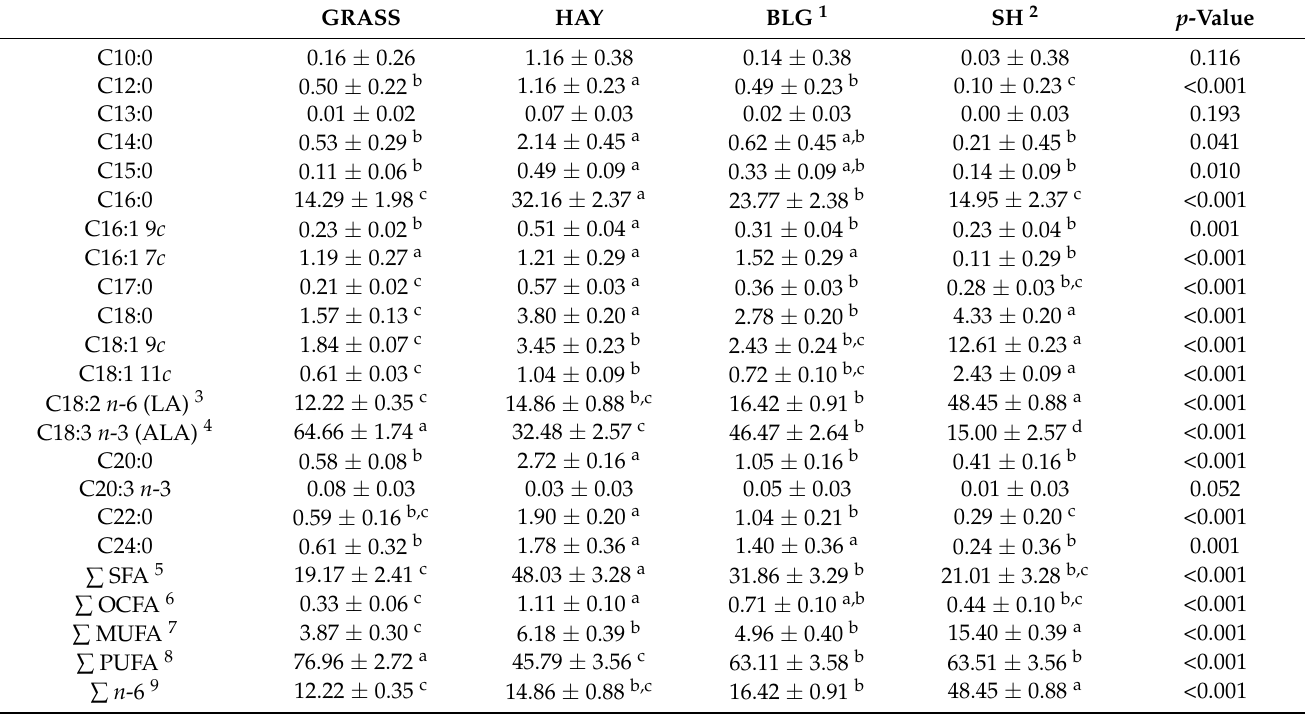
Table 2. Mean fatty acid composition of the diets (% total fatty